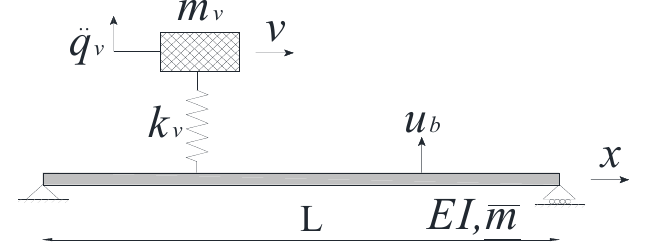
Figure 1. A simple VBI model.